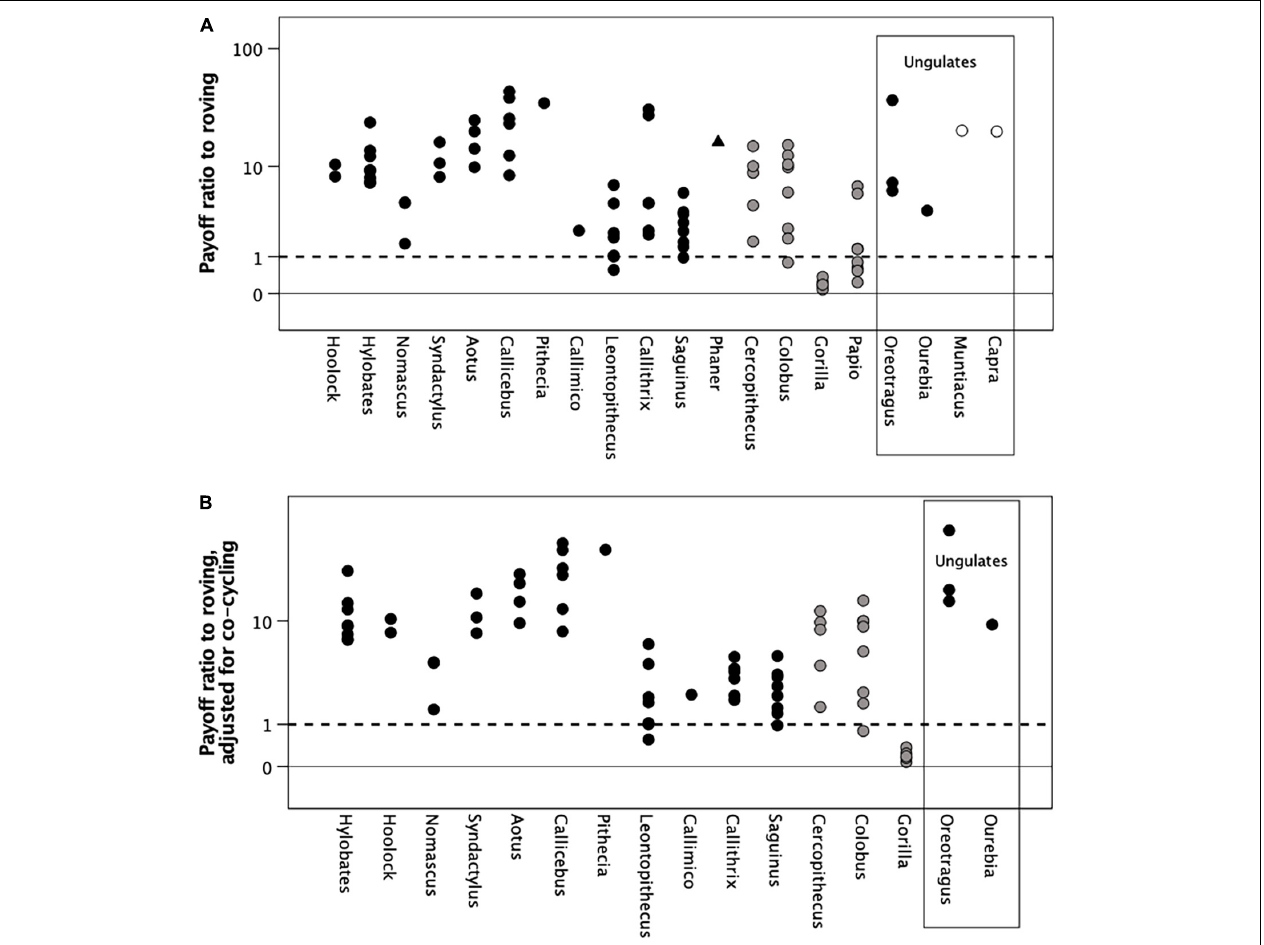
FIGURE 5 | (A) Payoff ratio to promiscuous males (“roving male strategy”) predicted by the male mating strategies model, for individual populations. The payoff ratio is the number of offspring sired during the average population-specific reproductive cycle (i.e., interbirth interval) by a promiscuous roving male divided by that expected for a social male (equivalent to female group size, as in Figure 2 ). The dashed line at a ratio of 1 indicates the point of equilibration where the payoffs are equal and males should be ambivalent about which strategy to adopt. When the ratio lies above this line, males would do better by opting for roving male polygamy; when it falls below, they would do better by opting to be social (i.e., permanently attaching themselves to a group of females). (B) The same values as in panel (A) adjusted for the probability that two or more females would be in oestrus at the same time (see Supplementary Figure 4 ), making it impossible for the male to mate with both. Filled symbols: social or dispersed monogamous groups; grey symbols: stable polygynous groups; unfilled symbols: roving male polygyny. Ungulate genera are enclosed in the box on the right; all other genera are primates. Y-axis is log 10